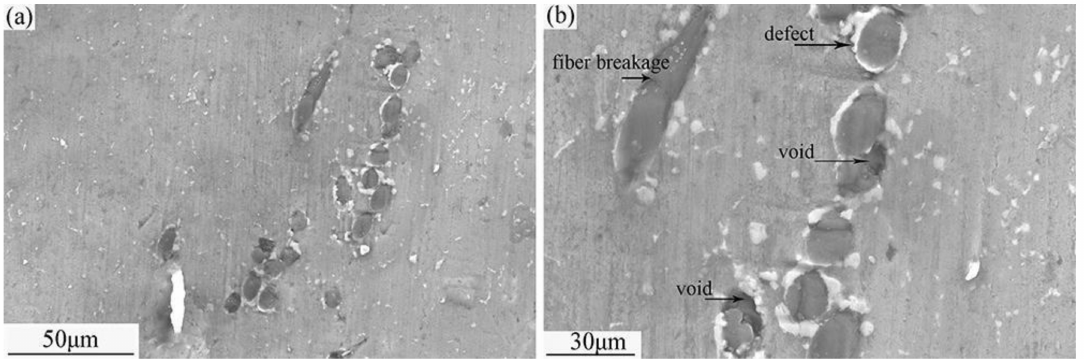
Figure 7. SEM microstructure of fiber agglomeration and defects in the aluminum matrix: ( a ) 2000 × ; and ( b ) 5000 × . The fiber content is 8%.